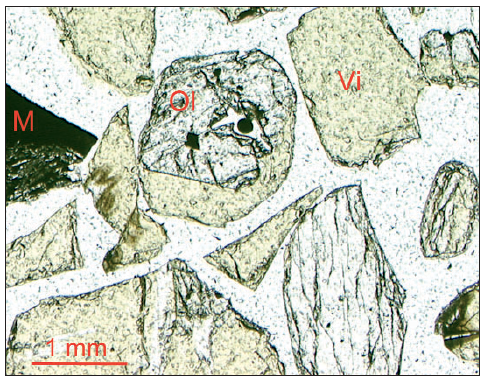
Fig. 2. Optical micrograph of vitreous particles from the black sand. Ol – olivine phenocrysts; M – magnetite; Vi – vitreous matrix.